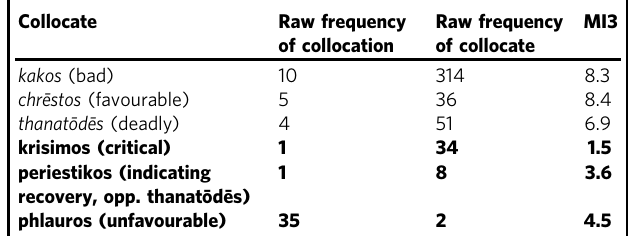
Table 10 Collocates of keyword S Ē MEION (all cases), raw frequency =